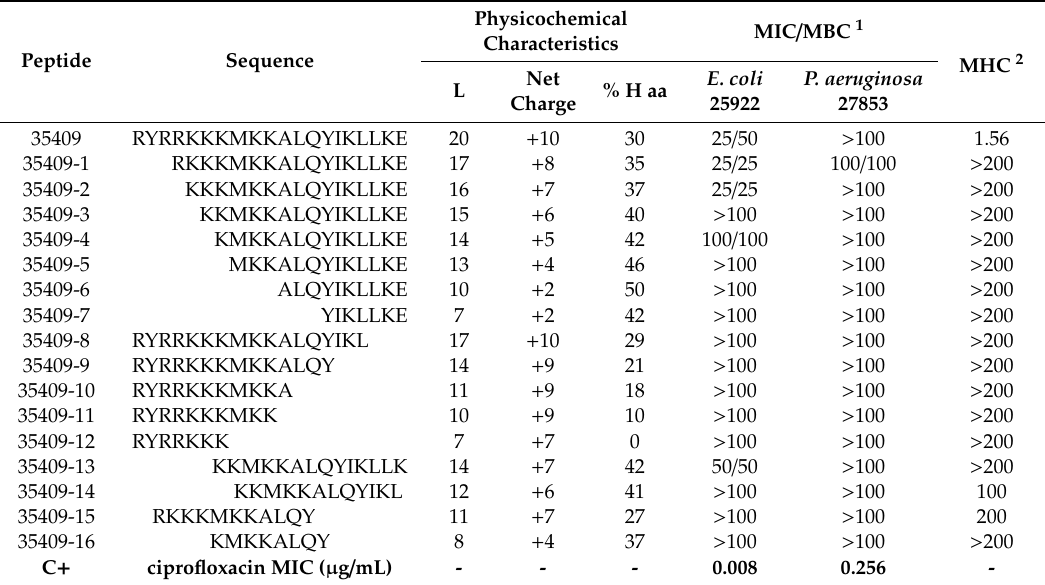
Table 1. 35409-derived peptides’ physicochemical characteristics and antibacterial activity. The peptides’ minimum inhibitory concentration (MIC), minimum bactericidal concentration (MBC) and minimum haemolytic concentration (MHC) are expressed in µ M.